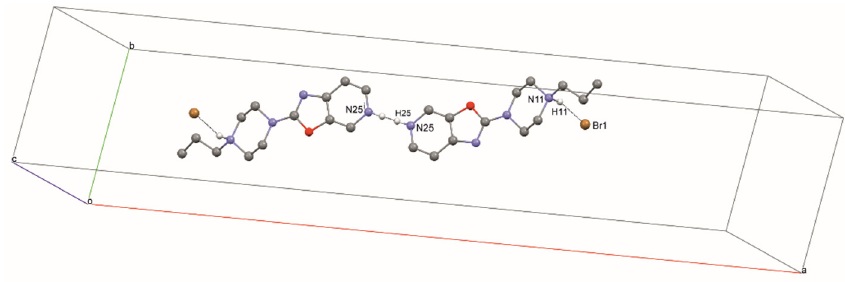
Figure 9. The crystal packing of 2 . Table 3. Strong hydrogen-bond geometry (Å, º) for 2 .